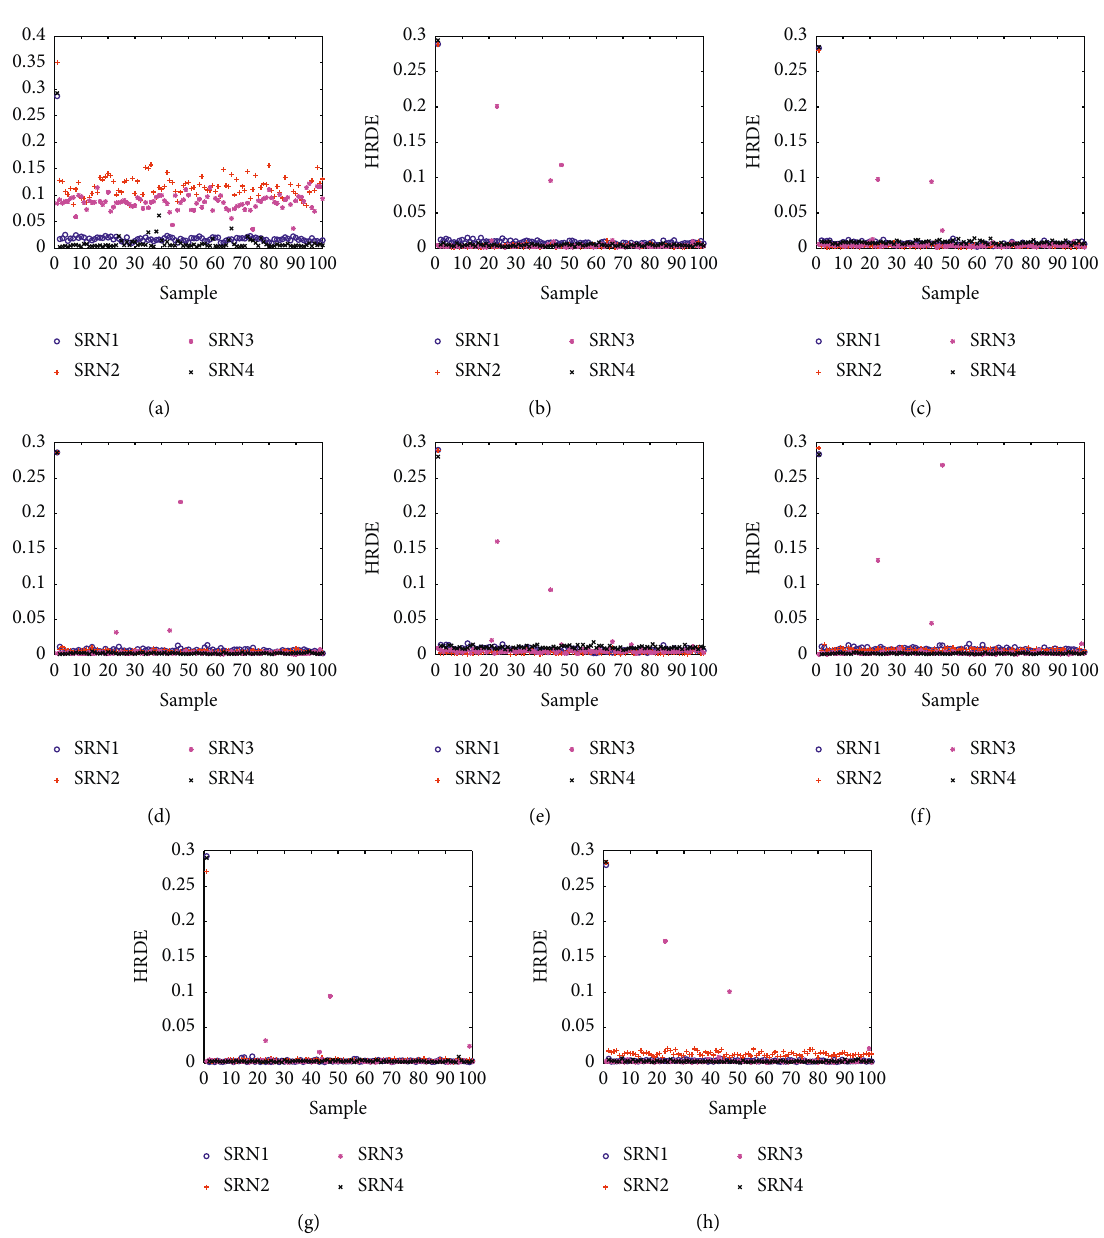
Figure 4: HRDE of eight nodes for four types of SRN. (a) Node 1. (b) Node 2. (c) Node 3. (d) Node 4. (e) Node 5. (f) Node 6. (g) Node 7. (h) Node